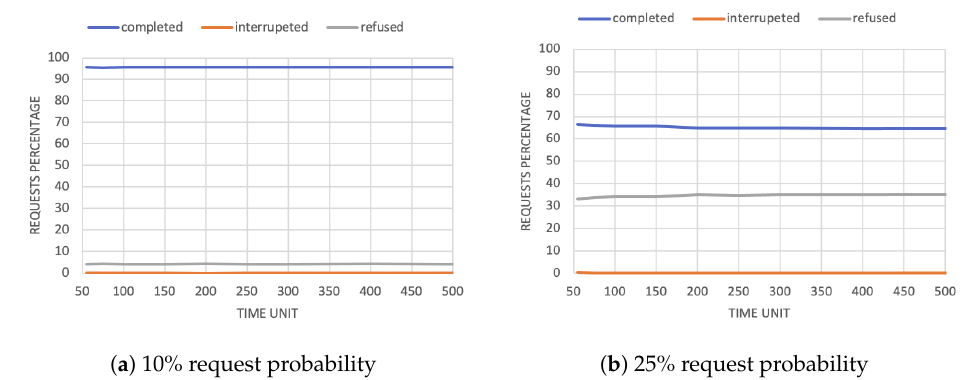
Figure 2. Percentage of completed, interrupted, and refused requests in the trustworthiness-based